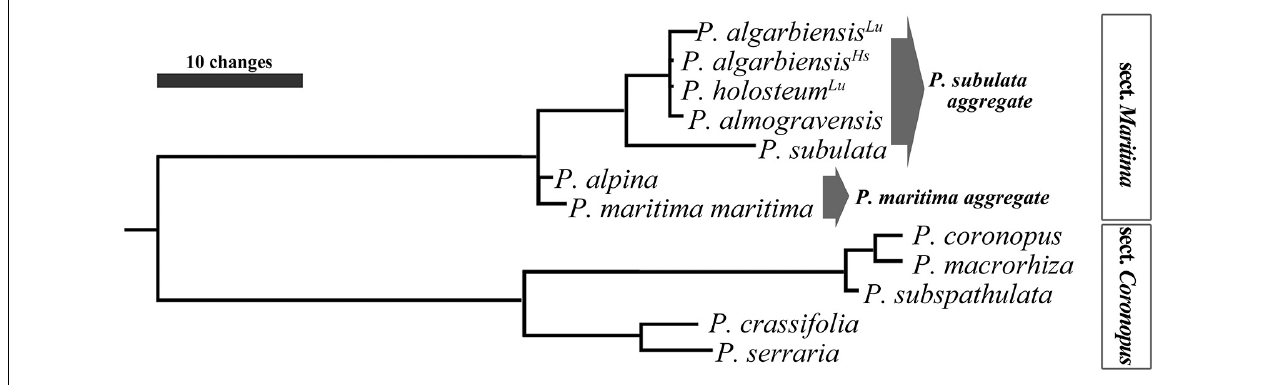
FIGURE 5 | Phylogram of Plantago subgen. Coronopus . Detail of the ITS + trnL-F strict consensus tree (Serrano, 2015). P. algarbiensis Lu : Portuguese population; P. algarbiensis Hs : Spanish population; P. holosteum Lu : syn. P. radicata , Portuguese populations. The sequences of the sister species P. almogravensis , P. algarbiensis (Lu & Hs), and P. holosteum analyzed share from 99.56% to 99.81% identity. Their 1,864-bp aligned matrix differs in eight base positions, six uncertain due to unresolved ambiguities and three with different bases or gaps. In comparison, P. subulata shares from 98.45% to 98.51% identity with those paraphyletic taxa in the same aggregate. Figure from Serrano (2015), p. 160.